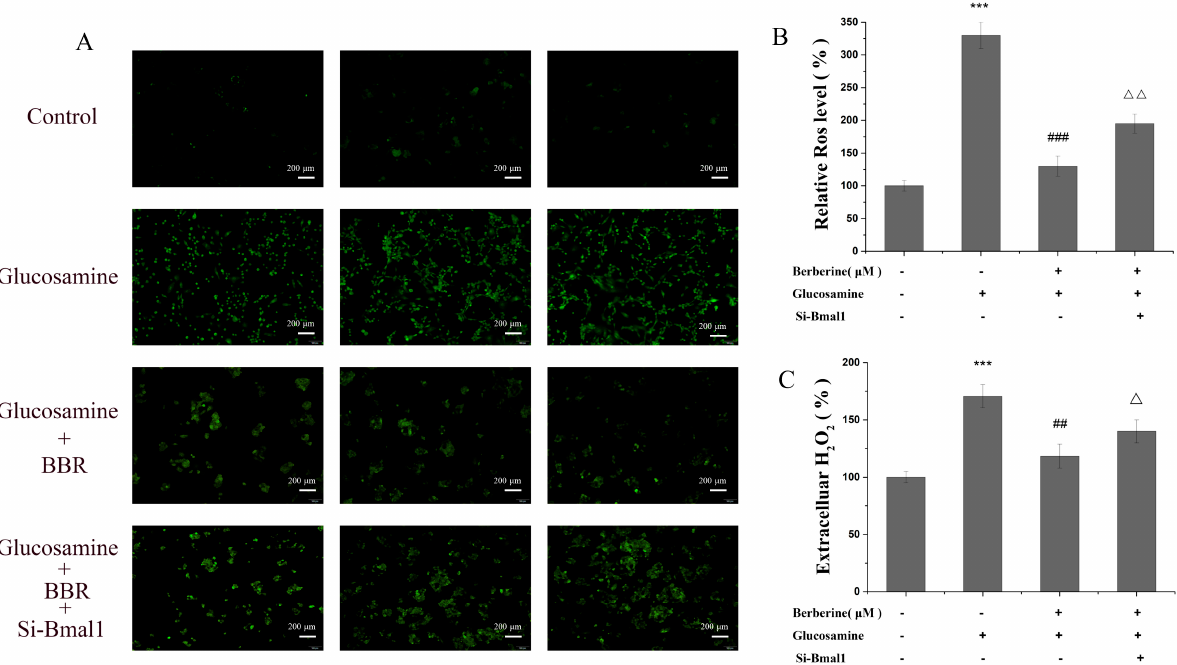
Figure 4. BBR reversed glucosamine-induced redox imbalance in HepG2 cells. ( A , B ) The status of ROS level in different groups was detected using DCFH-DA to examine the cellular oxidation status. ( C ) Production of H 2 O 2 measured by a commercial kit. All data are presented as the mean ± SEM ( n = 3). *** p < 0.001 compared to the control group; ## p < 0.01, and ### p < 0.001 compared to the glucosamine group; ∆ p < 0.05, and ∆∆ p < 0.01 compared to the glucosamine plus BBR group.